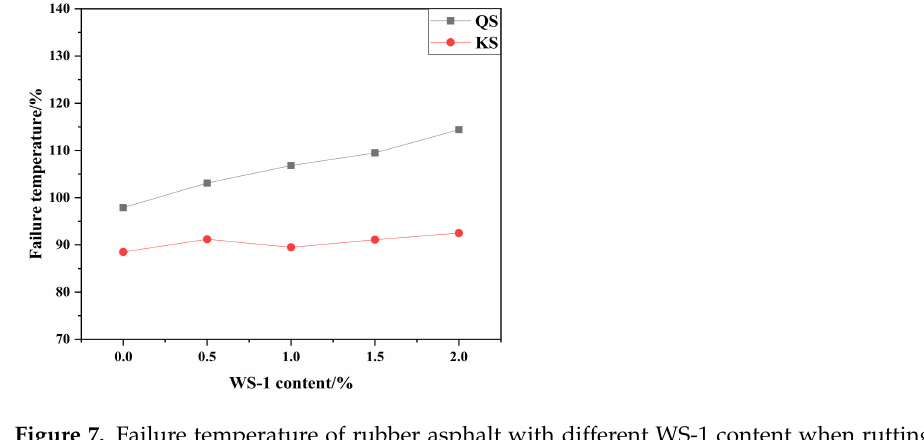
Figure 7. Failure temperature of rubber asphalt with different WS-1 content when rutting factor G*/sin δ = 1.0 kPa.